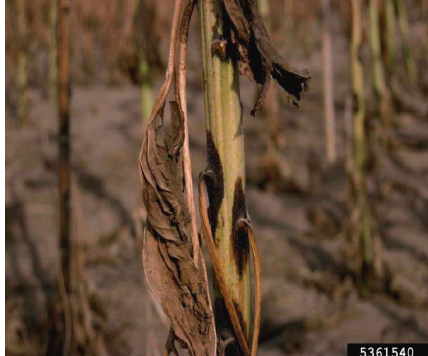
Figure 3: Phoma blight.